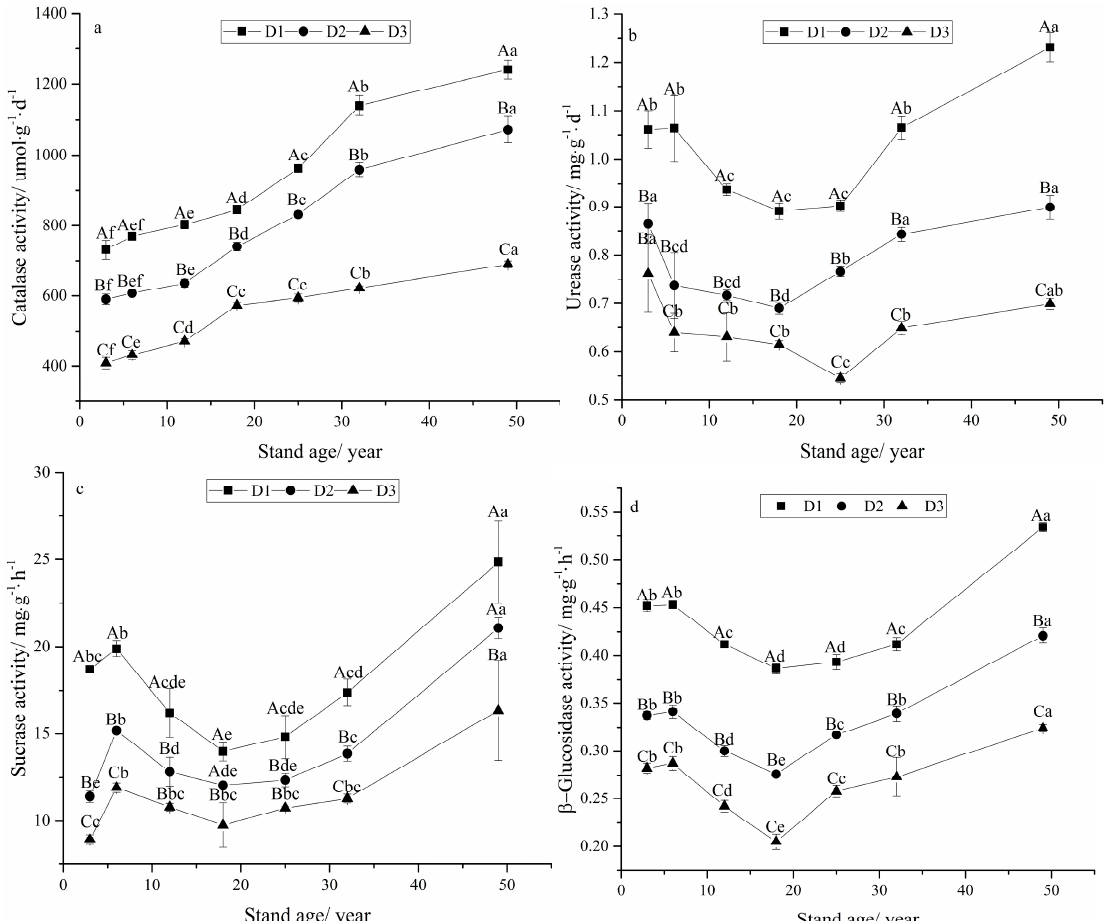
Figure 3. The soil enzyme activities of plantations of different ages. ( a ) catalase activities in different stand ages and different soil depths, ( b ) urease activities different stand ages and different soil depths, ( c ) sucrase activities different stand ages and different soil depths, ( d ) β -glucosidase activities in different stand ages and different soil depths. Different lowercase letters and different uppercase letters represent significant differences between the same soil depth of different stand ages and between different soil depths of the same stand age at p < 0.05, respectively.